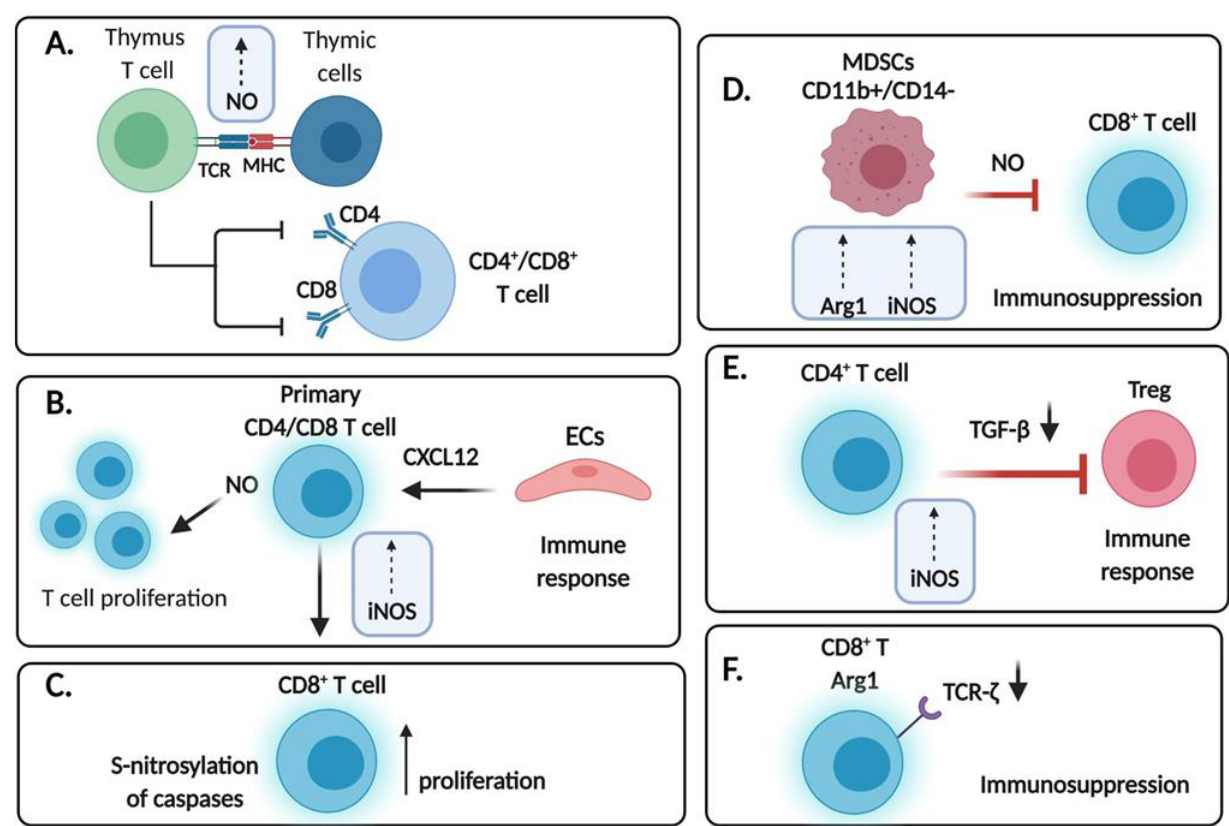
Figure 1. Regulation of T cells by endogenous .NO. ( A ) Increased iNOS and .NO production in thymic cells were found to induce apoptosis and depletion of double positive CD4 + /CD8 + T lymphocytes. ( B ) Endothelial cells (ECs) induce iNOS expression in primary CD4/CD8 T cells, resulting in T cell proliferation likely due to CXCL12 expression and leading to an anti-tumor immune response. ( C ) iNOS expression reduces the number of T cells due to cytokine deprivation-induced cell death likely due to S-nitrosylation of caspases. ( D ) Expression of iNOS and resulting .NO in CD11b + /CD14 − MDSCs suppress the anti- tumor response of CD8+ T cells. ( E ) .NO-mediated suppression of TGF- β is due, in part, to the expression of iNOS in CD4+ T cells to inhibit differentiation of CD4 T cells into Treg cells; thus, enhancing the anti-tumor immune response. ( F ) Increased levels of the iNOS inhibitor, Arg1, results in the downregulation of the TCR ζ -chain, resulting in